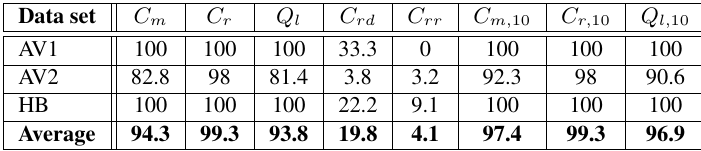
Table 2. Pixel-based and geometric evaluation results in AV1 - first Aitkenvale, AV2 - second Aitkenvale and HB - Hervey Bay scenes. ( C mp = completeness, C rp = correctness, Q lp = quality, B f = branching factor and M f = miss factor in percentage. RMSE = root-mean-square-error in